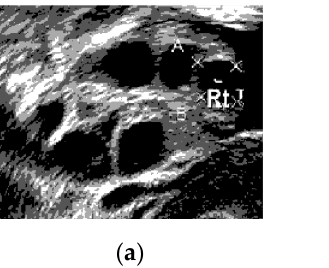
( d) Figure 12. Comparison images of different segmentation methods. ( a ) Original ultrasound image; ( b ) follicles marked by medical expert; ( c ) classical Chan – Vese method; and ( d ) Otsu thresholding and the Chan – Vese method. Figure 13 shows another ultrasound image with three different segmentations: man- ual segmentation, classical Chan – Vese, and the proposed segmentation method. This